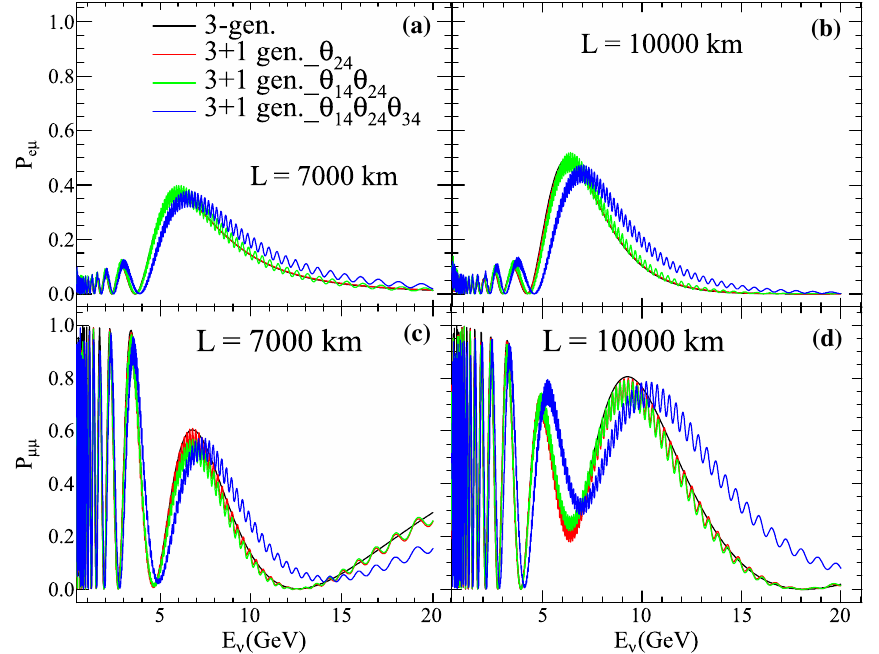
Fig. 2 The neutrino oscillation probability P e μ ( top panels ) and P μμ ( bottom panels ) as a function of neutrino energy. The left-hand pan- els ( right-hand panels ) are for a neutrino trajectory corresponding to a baseline of L = 7000km ( L = 10 , 000km) inside earth. The black lines correspond to the 3 generation case, while the red , green , and blue lines correspond to the 3 + 1 scenario. Specifically, the red lines are for